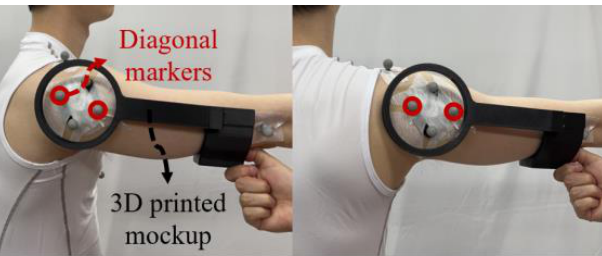
Figure 2. Description of the cluster position and orientation based on a 3D-printed mock-up.